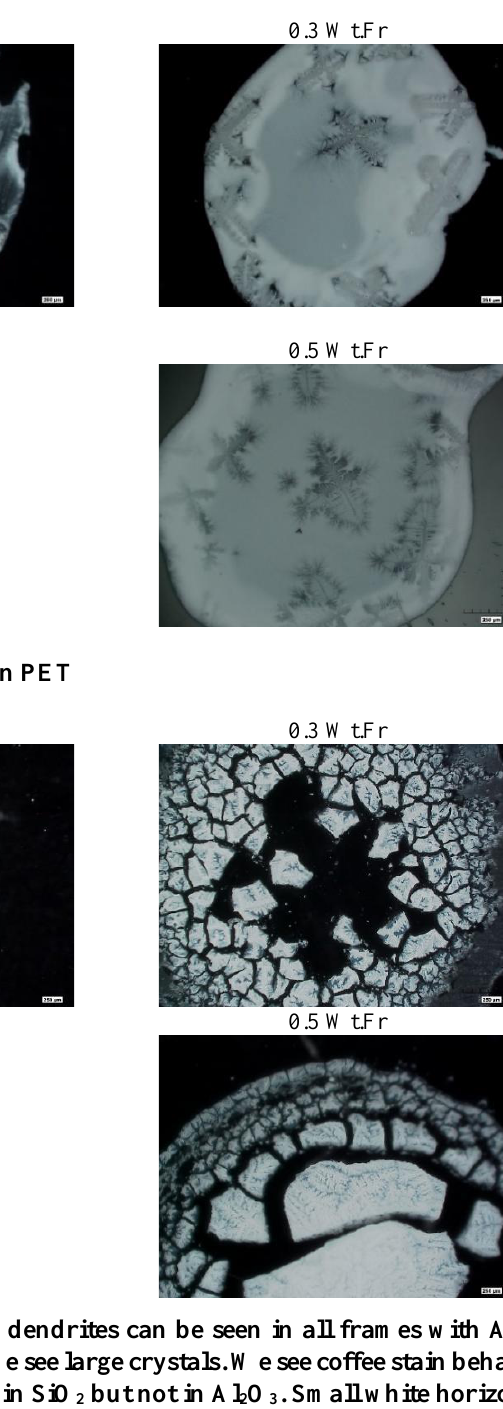
O . Small white horizontal 2 3